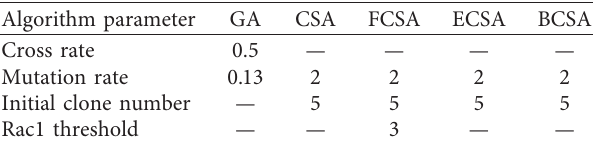
Table 1: Initialization parameters. Algorithm parameter